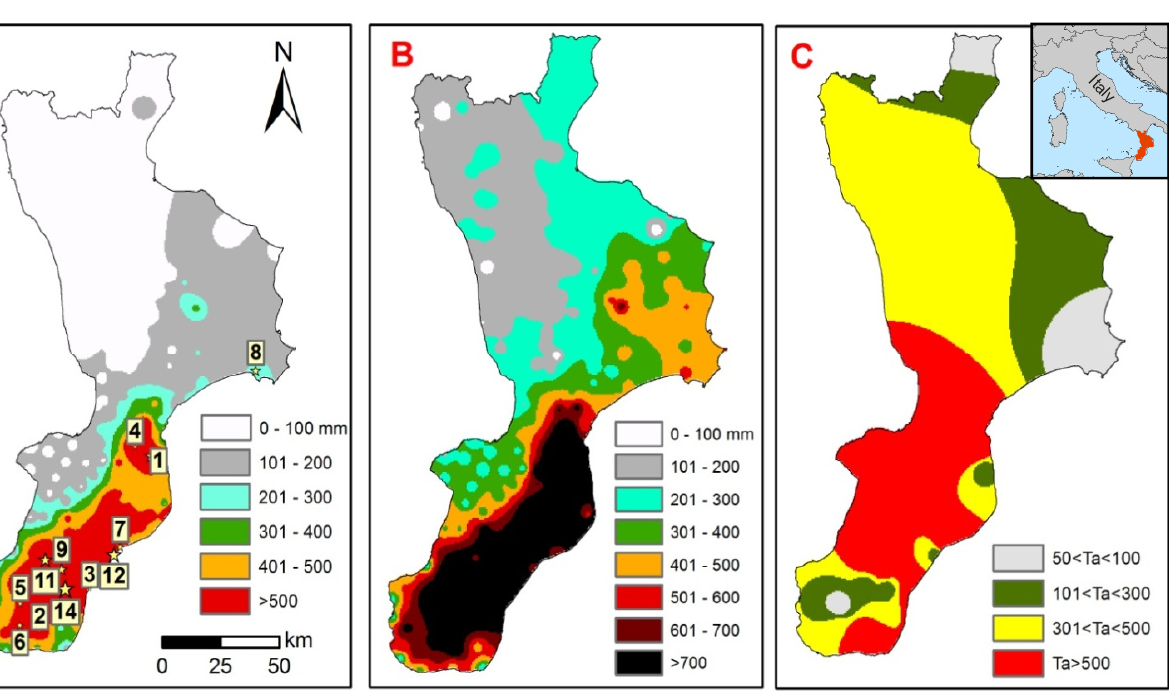
Figure 2. ( A ) The classification of Calabria according to the accumulated rain of October 16–19, 1951 (mm); ( B ) The accumulated rain recorded in the region during October 1951 (mm); ( C ) The regional classification according to the return period of the rain (average value T ) and the location of the study a